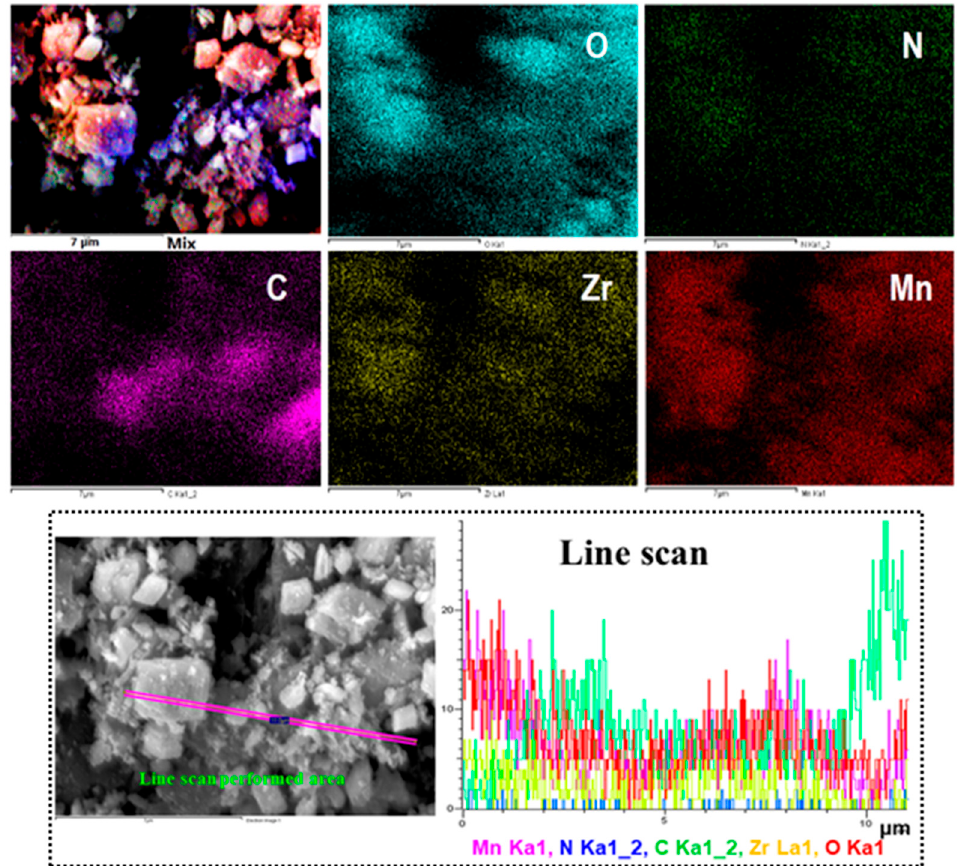
Figure 5. FE-SEM elemental mapping and line scan profile of (1%)NDG/MnCO 3 –(1%)ZrO 2.